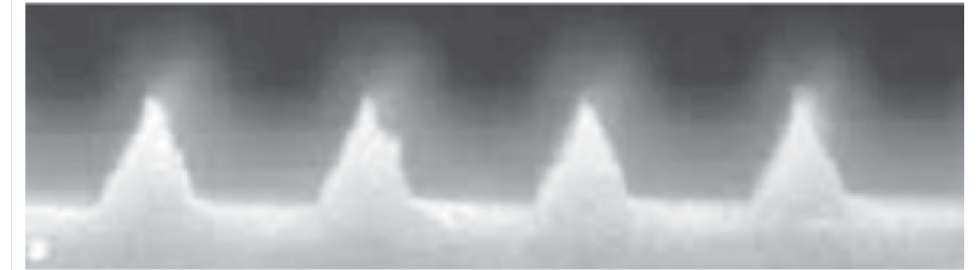
Figure 2. A photograph presenting a cross-sectional plane of the